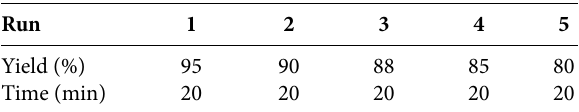
Table 3. Recyclability of Fe 3 O 4 @PyHBr 3